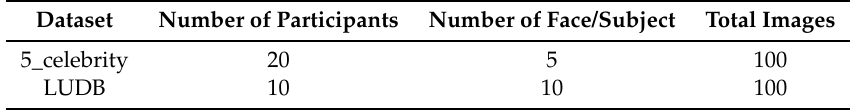
Table 1. Dataset used during this